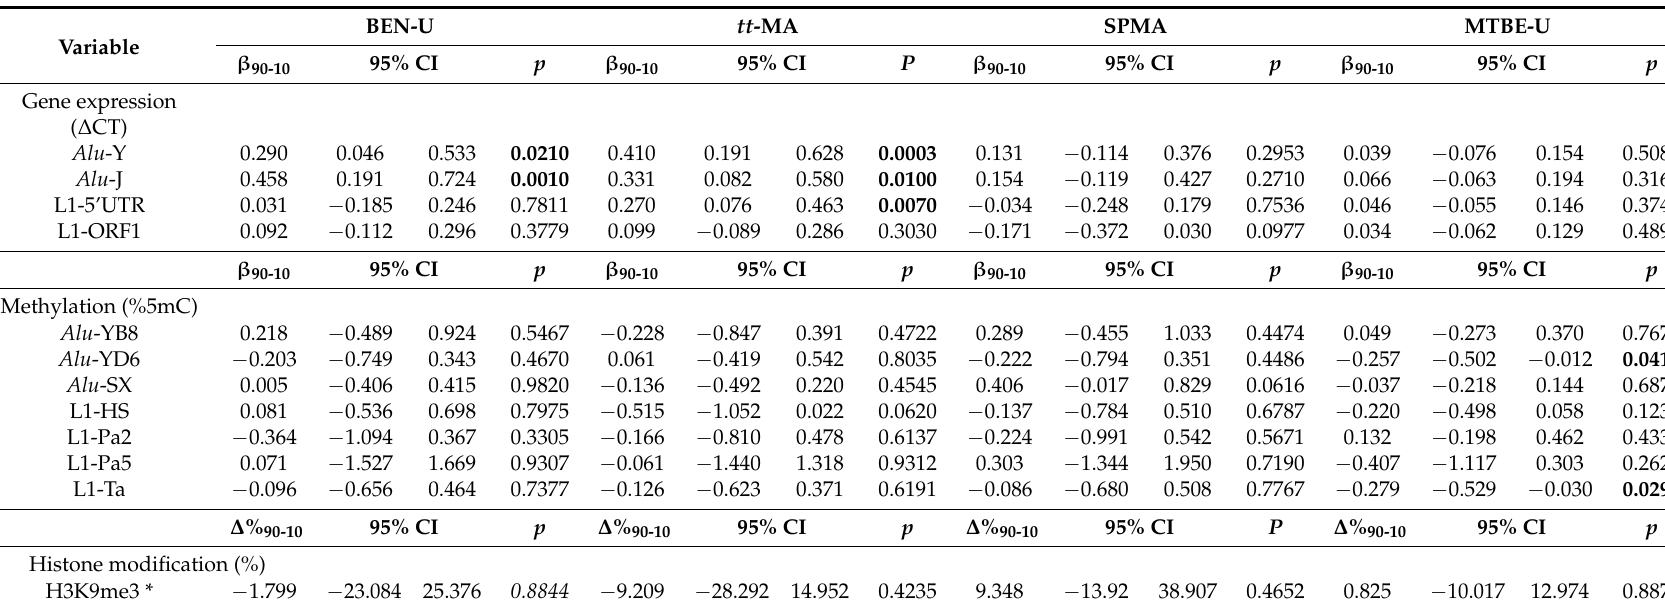
Table 4. Association between gene expression, DNA methylation, and histone modification in peripheral blood lymphocytes and urinary biomarkers of exposure in all study subjects ( n = 179